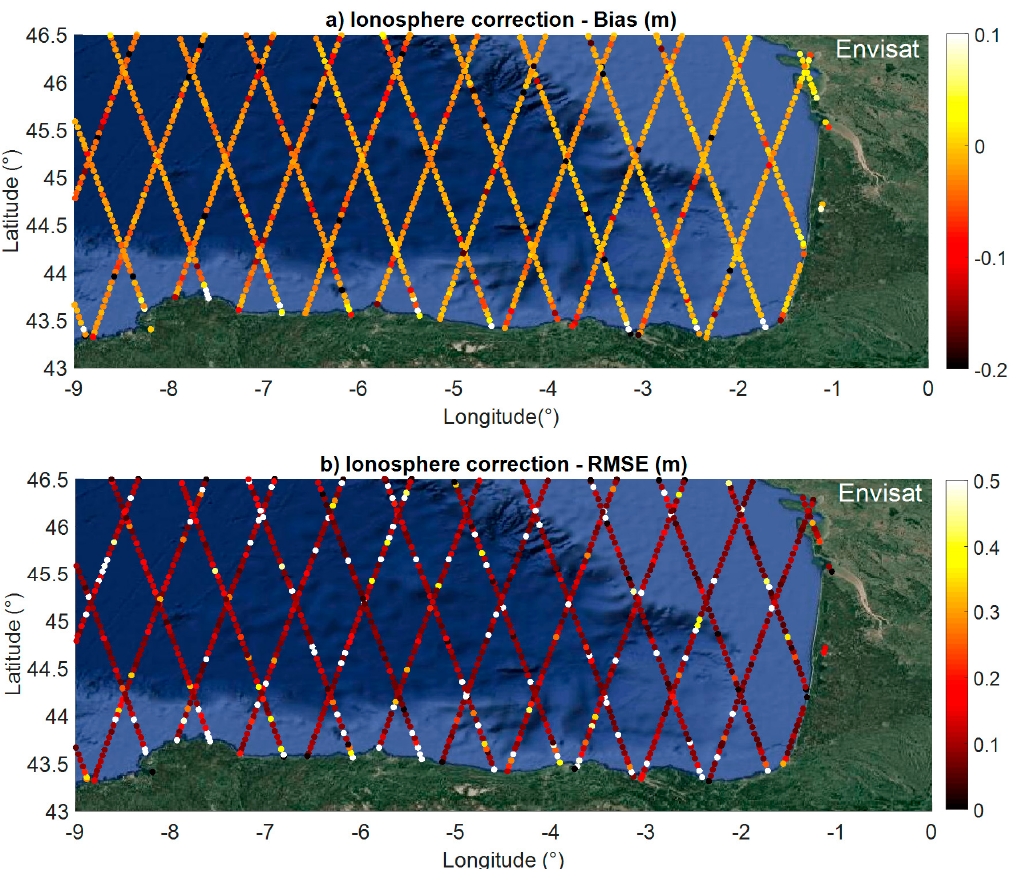
Figure 6. Comparison between the ionosphere corrections from bi-frequency measurements and the GIM model for Envisat: ( a ) bias and ( b ) RMSE. Remote Sens. 2018 , 10 , 93